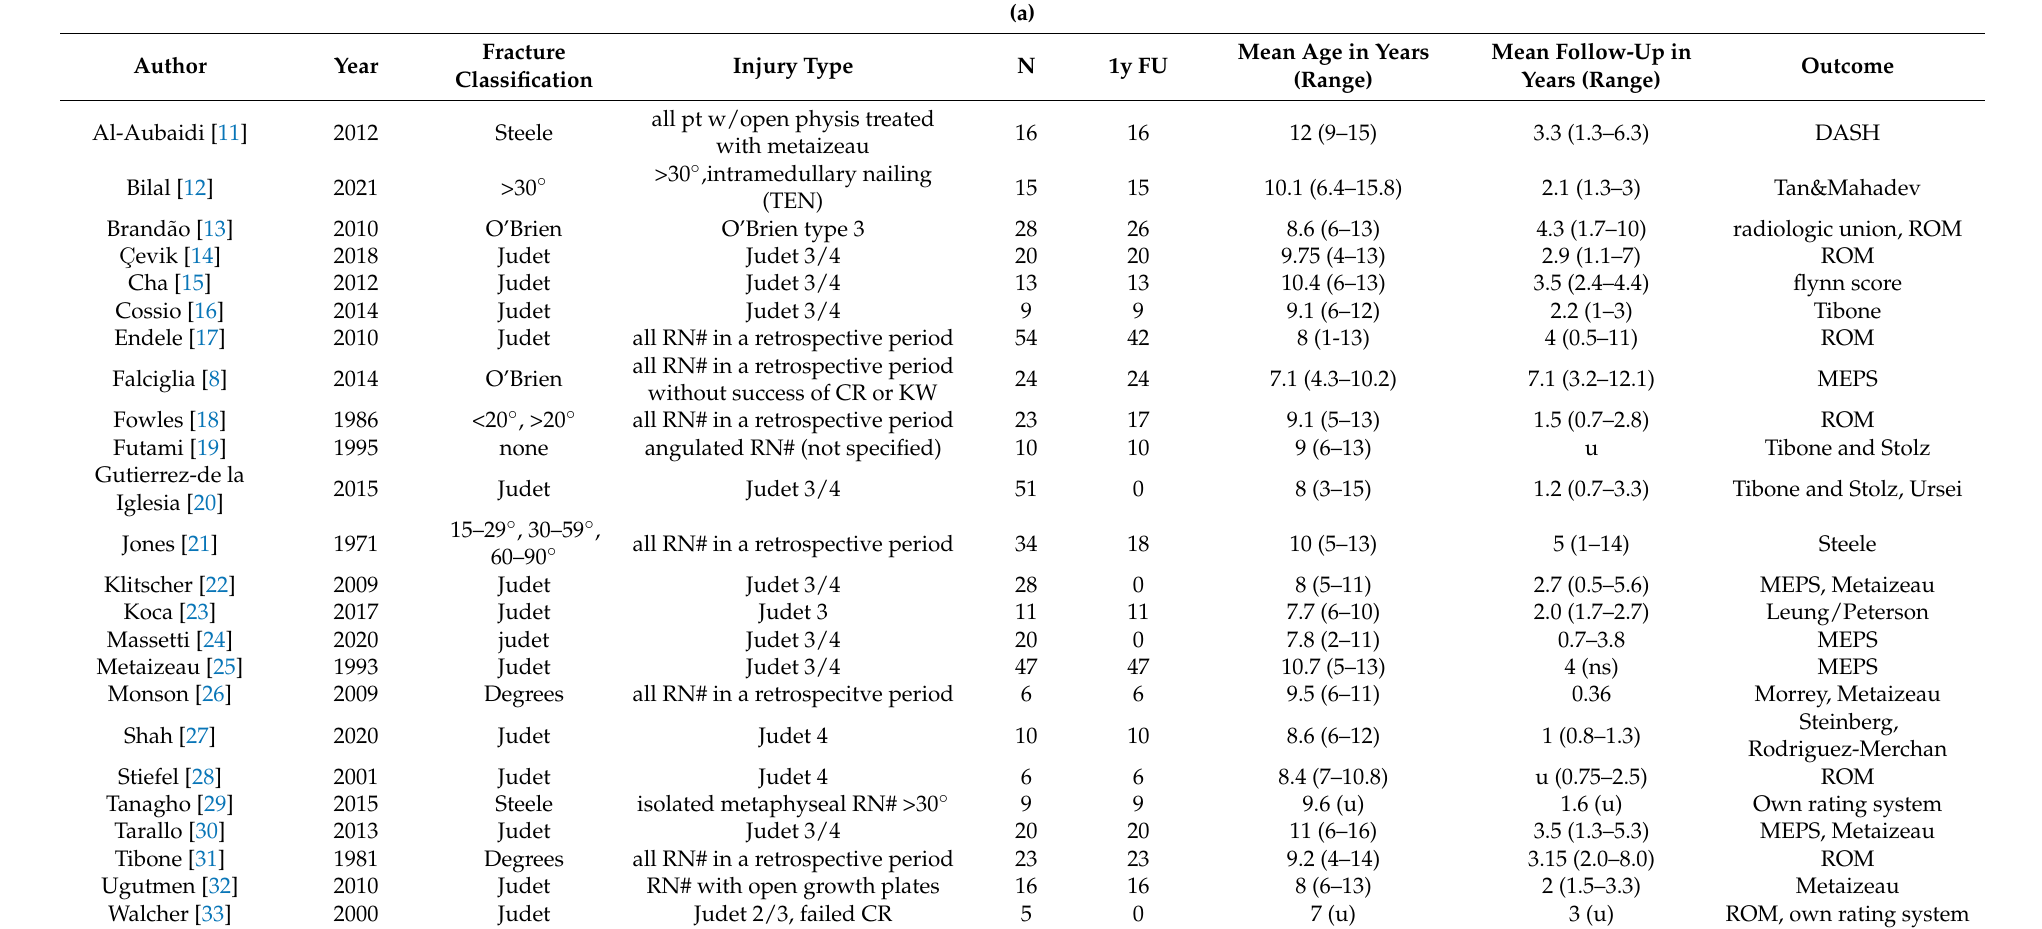
Table 3. Part a: Overview of included articles, part b: MINORS criteria.